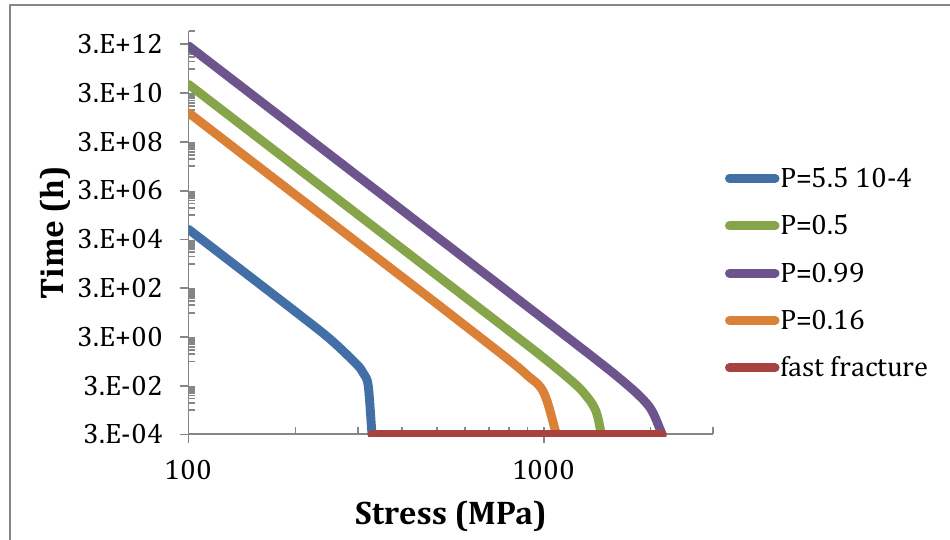
Figure 4. Stress-Time-Probability diagram for filaments defined by selected values of the failure probability: P = 5.5 × 10 −4 (= 1/1824) for the weakest filament in tow, P = 0.16 for the critical filament defined by α t (Equation (12)), P = 0.5 for the average filament, and P = 0.99 for the strongest filament. Fast fracture occurs when the applied stress is equal to the filament strength.